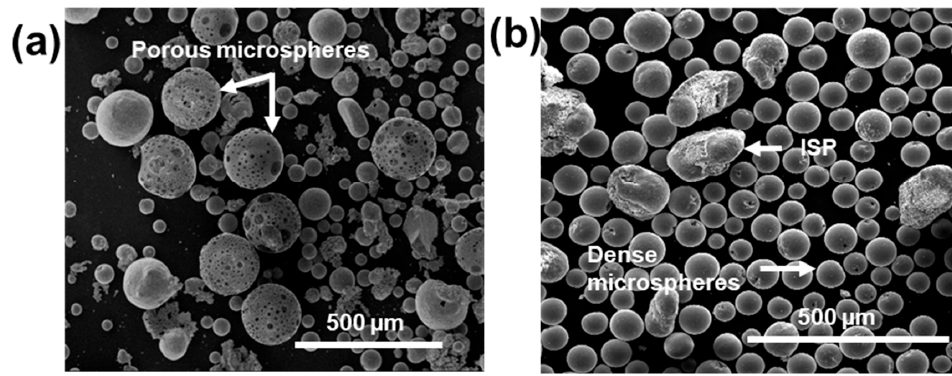
Figure 5. SE images of flame-spheroidised Fe 3 O 4 :CaCO 3 (1:1 mass ratio). Gas flow settings: ( a ) 2:2 and ( b ) 3:3 (unsieved). ISP: irregular-shaped particles.